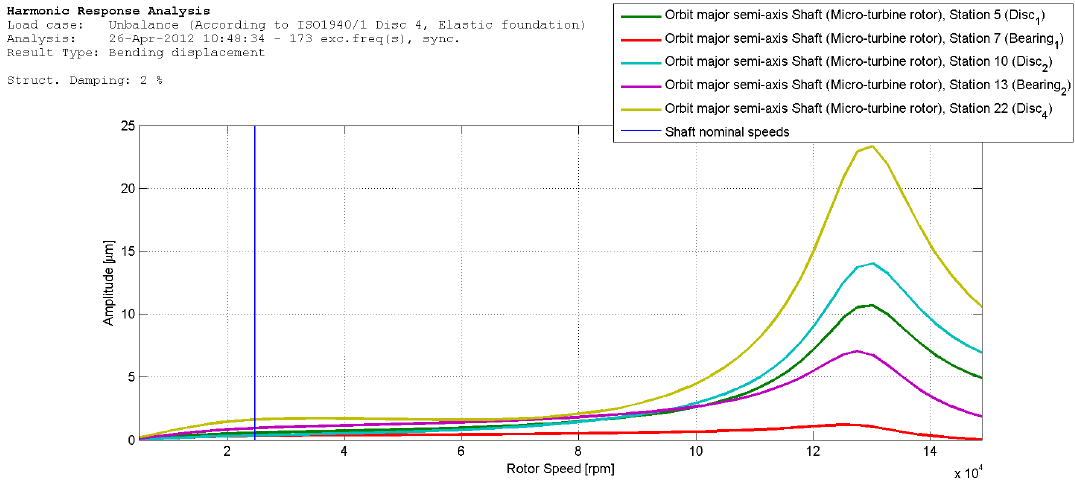
Figure 19: Amplitude of the rotor vibration taking into account the compliance of the bearing supports (stiffness of the supports was 5 times greater than the designated static stiffness).